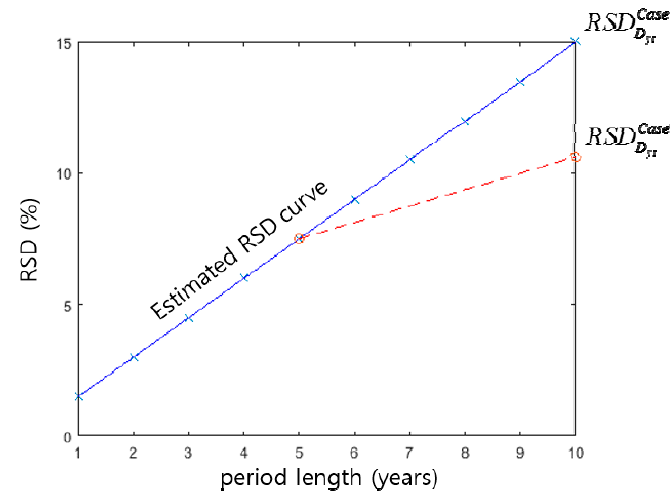
Figure 9. Estimated RSD curve and calculated RSD values.